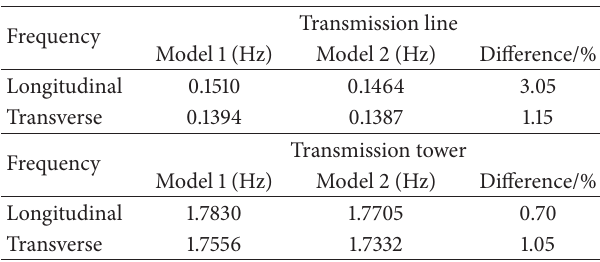
Table 4: Comparison of the fundamental frequencies of the tension type model.